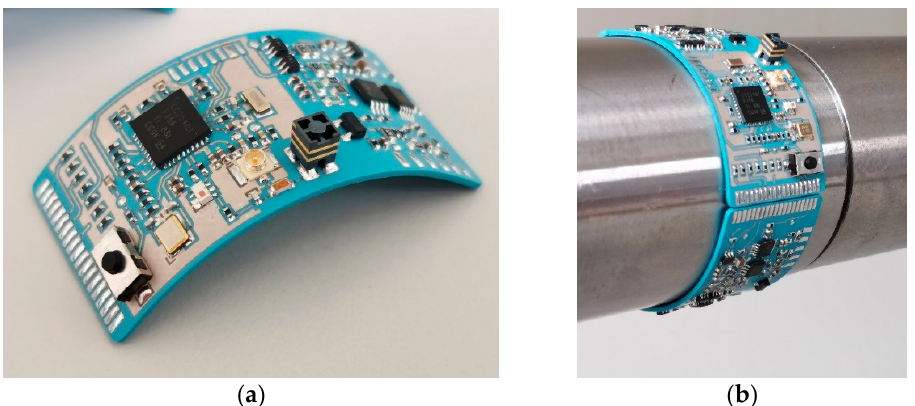
Figure 11. Shaped substrate fully equipped and ready to use manufactured by Mirco Systems Engineering GmbH. ( a ) fully equipped substrate; ( b ) equipped substrate placed on the steel shaft as in the intended use.